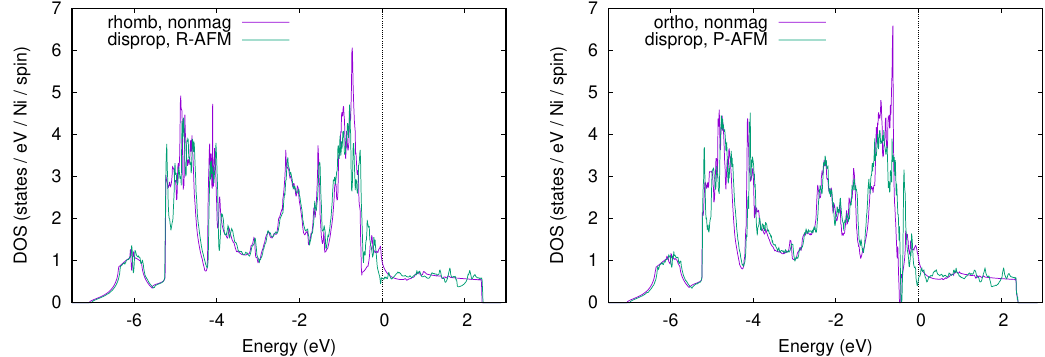
Figure 7: Left: Calculated electronic DOS of LaNiO magnetic and disproportionated antiferromagnetic R -type structures. Right: DOS of LaNiO in the orthorhombic non-magnetic and disproportionated antiferromagnetic 3 P -type